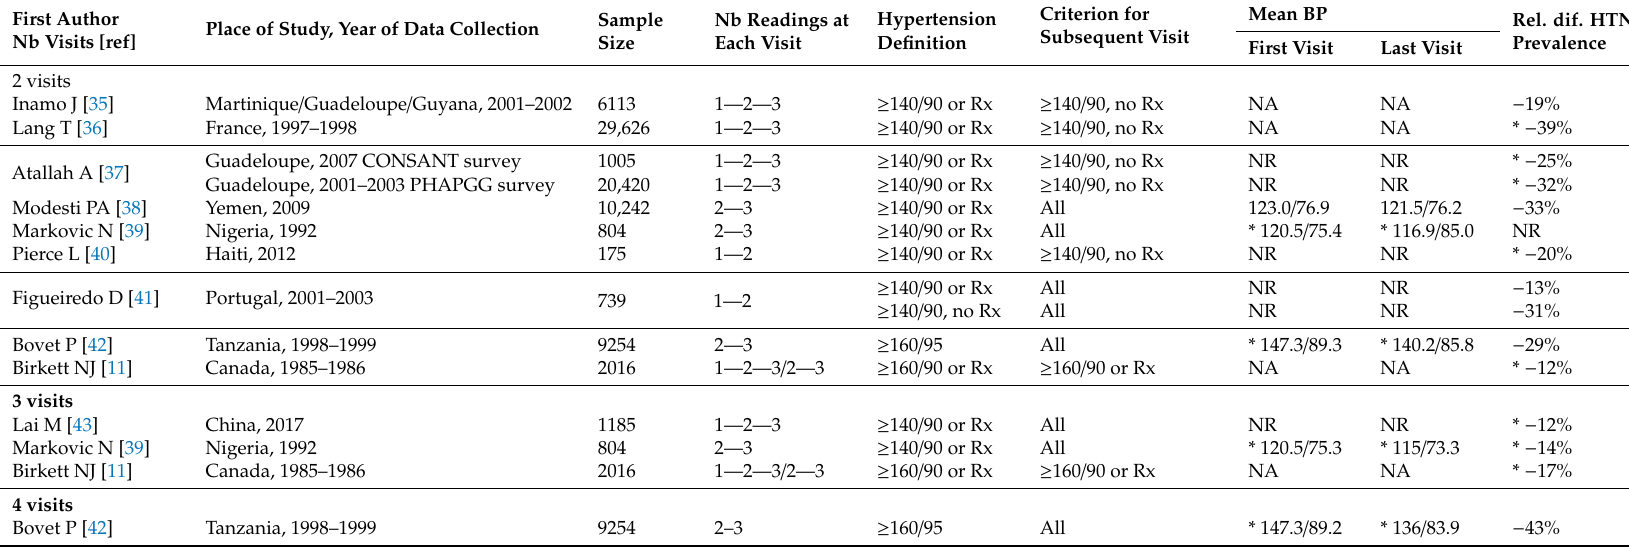
Table 6. Narrative review: Characteristics and main results of the community surveys that had assessed the di ff erence in the prevalence of hypertension based on blood pressure measured on ≥ two vs. one